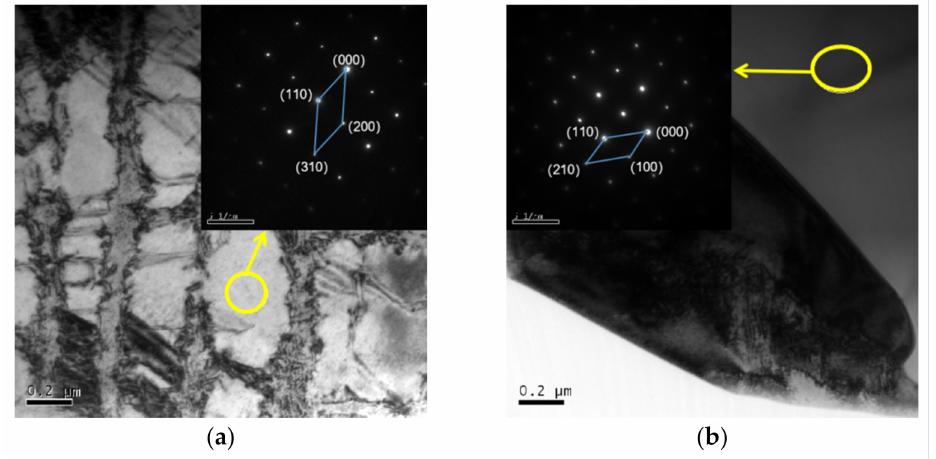
Figure 5. TEM analysis of Fe-25Mn-10Al-8Ni-C ( a ) austenite phase; ( b ) B2 phase (B2-NiAl). The phase in Fe-25Mn-13Al-8Ni-C alloy was analyzed by TEM, and the